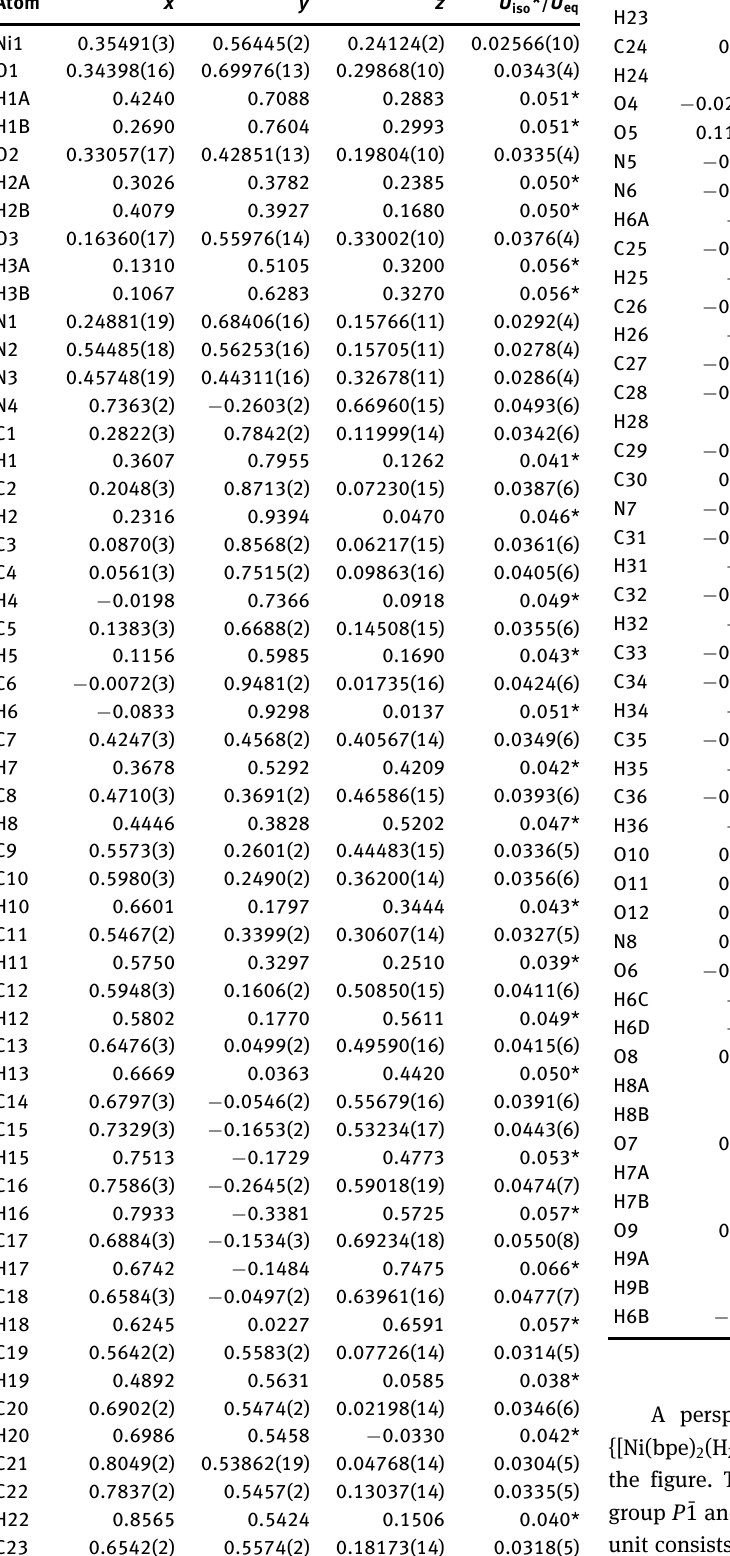
the figure. The complex crystallizes in the triclinic space group P ¯1 and exhibits a 1D chain structure. The asymmetric unit consists of one Ni(II) ion, two coordinated bpe